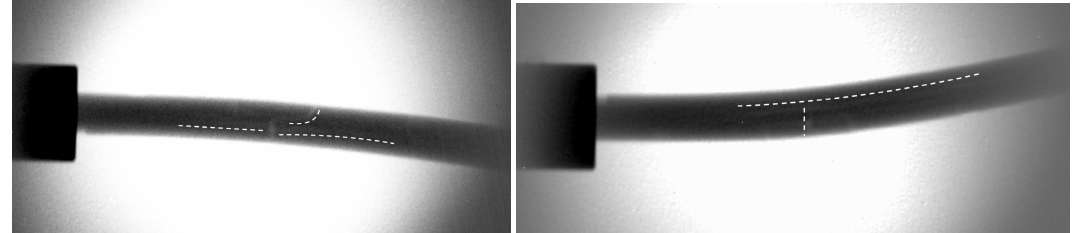
Figure 13. Radiographs of one of the HiRadMat-27 W rods before ( left panel ) and after ( right panel ) a rotation of 120 ◦ . Different fractures are visible depending on the orientation of the rod with respect to the neutron